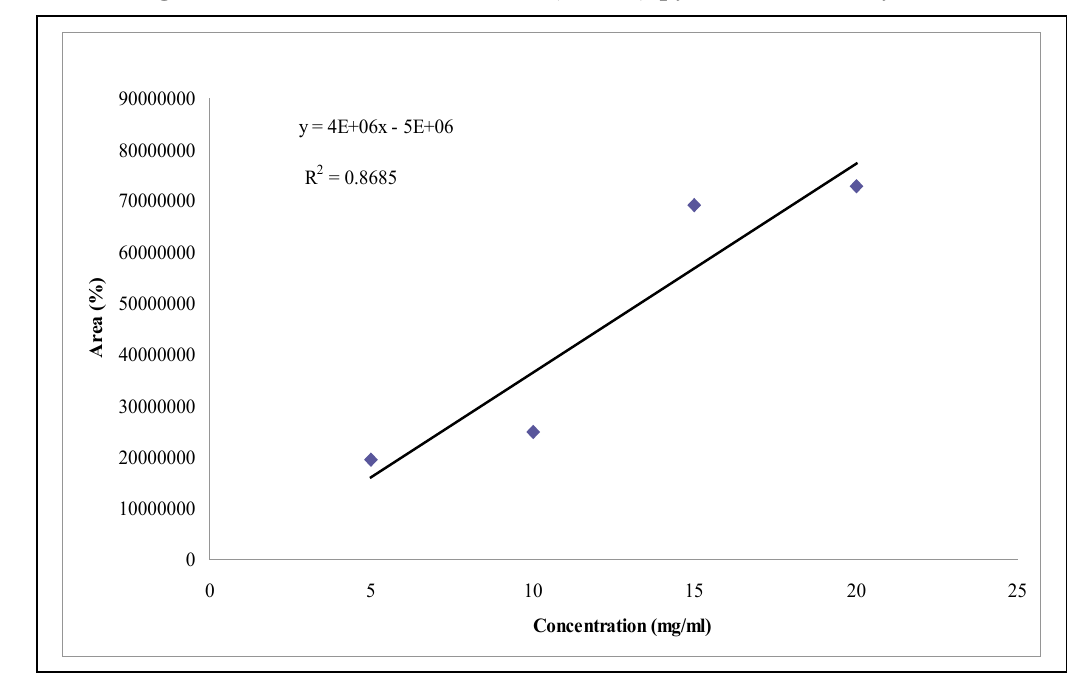
Figure 5. Calibration curve of 2 , 4-(1 H, 3 H ) - pyrimidinedione by